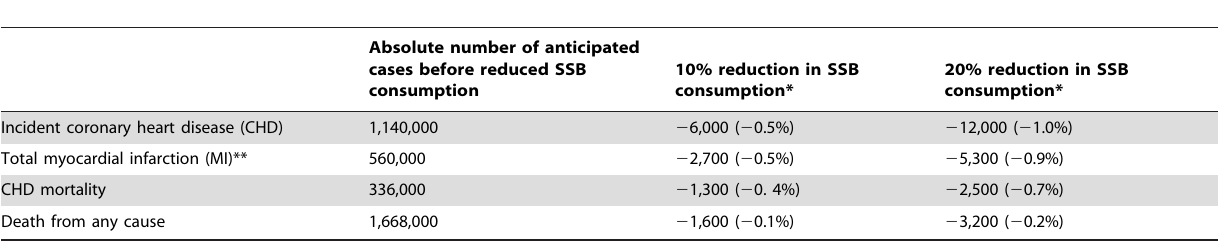
Table 2. Absolute number of coronary heart disease events and deaths prevented from a 10–20% SSB consumption reduction with moderate BMI effects from 2013–2022 in California (Percent